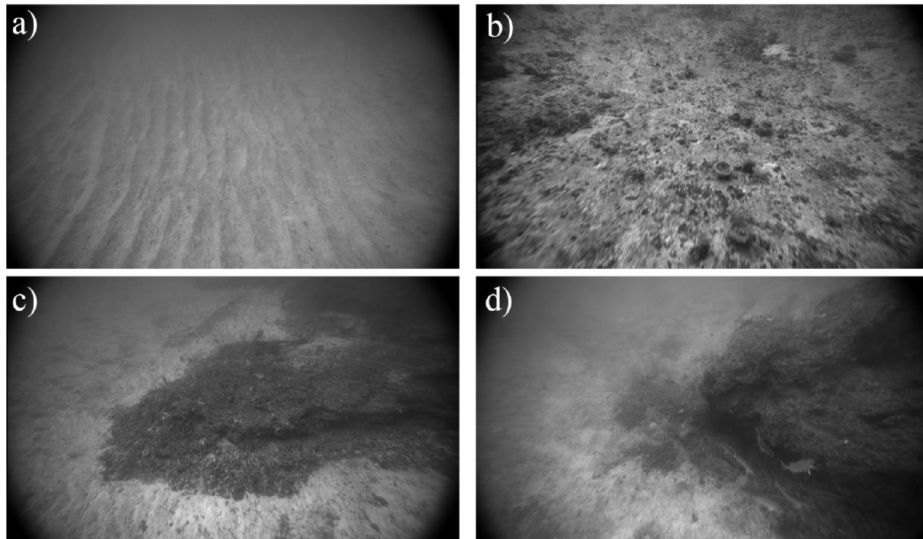
Figure 2. Substrate types observed in the Elbow of the west Florida shelf include sand ( a ) and rock substrate of varying levels of relief: low ( b ), moderate ( c ), and high ( d